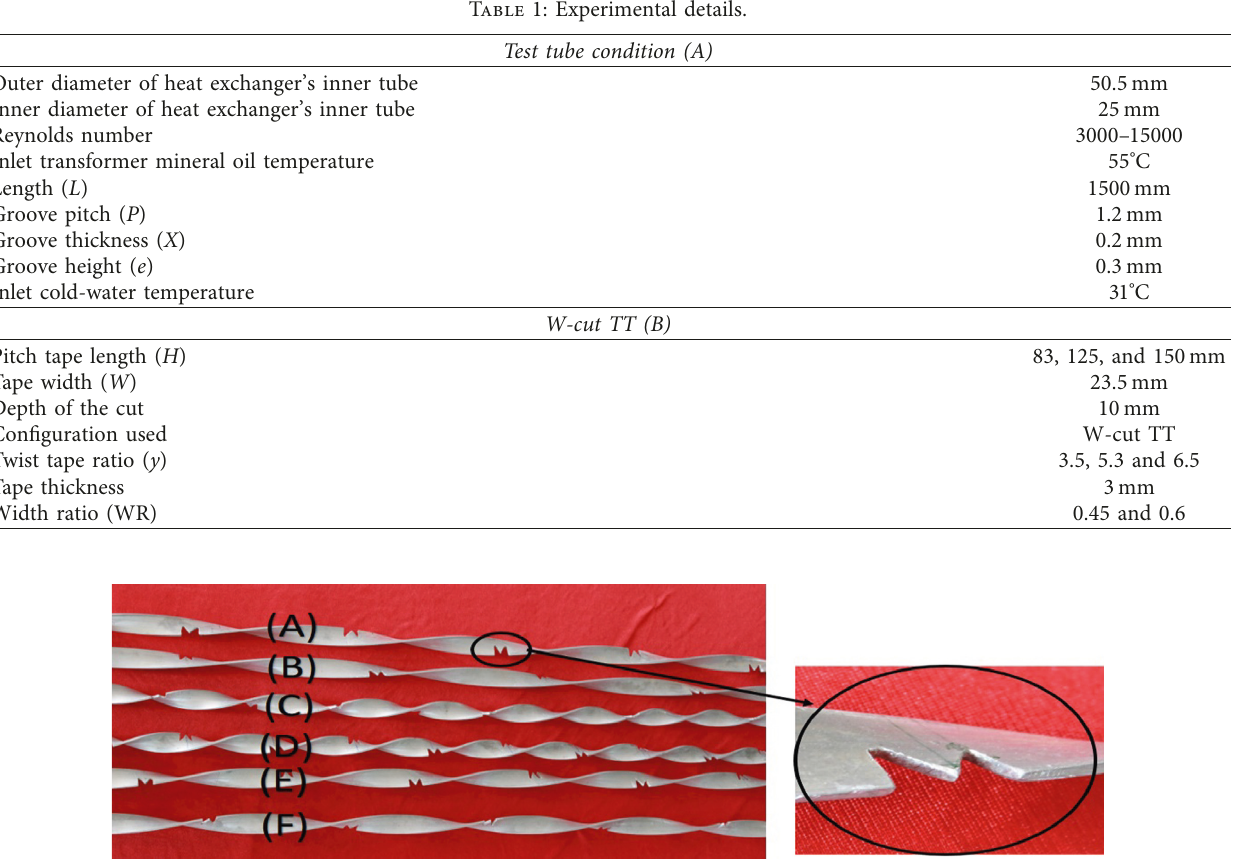
Figure 3: Configuration of W-cut TT: (a) y � 6.4, WR � 0.6; (b) y � 6.4, WR � 0.45; (c) y � 5.3, WR � 0.6; (d) y � 5.3, WR � 0.45; (e) y of 5.3, WR � 0.6; (f) y of 5.3, WR �